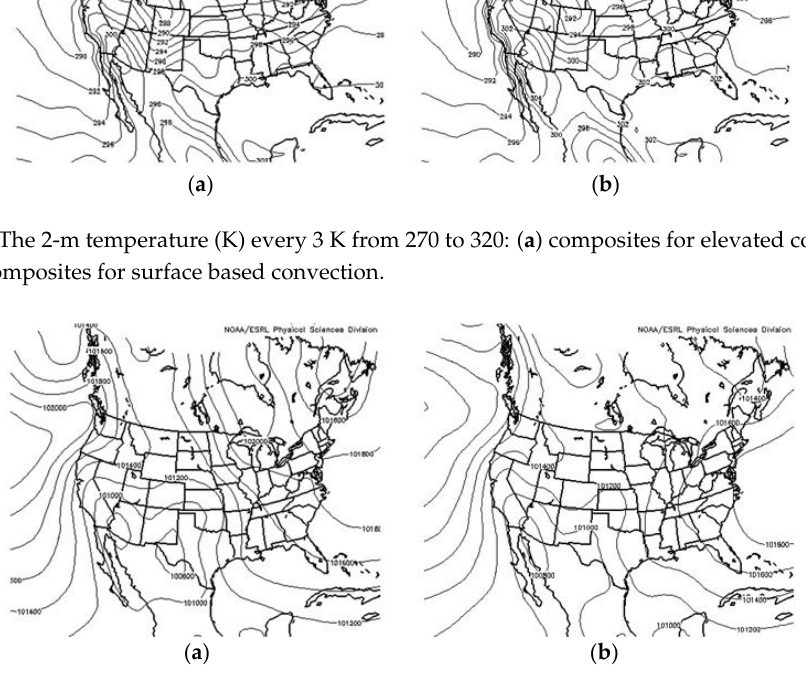
Figure 9. Pressure reduced to mean sea level; every 200 Pa from 100,000 to 10,300: ( a ) composites for elevated convection; and ( b ) composites for surface based convection.